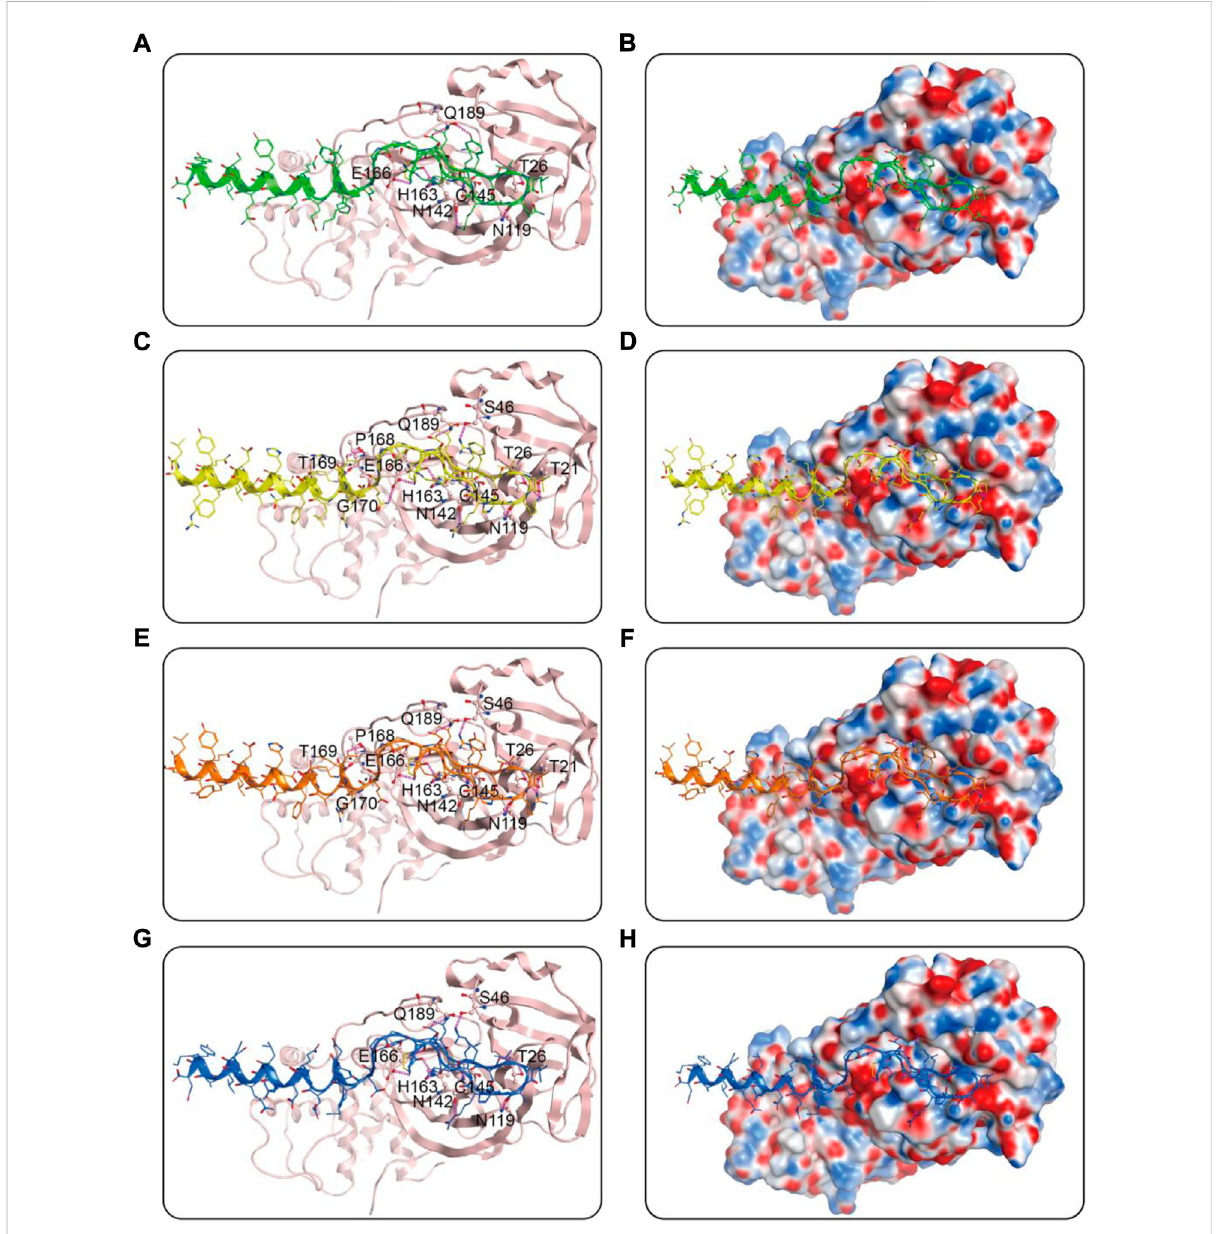
FIGURE 3 Predicted binding modes of MRs 1-4 in the active site of Mpro: (A , B) MR-1; (C , D) MR-2; (E , F) MR-3; (G , H) MR-4. The MRs 1-4 were represented asstickswiththeatomscoloredasnitrogen-blue,oxygen-red,sulfur-yellowandcarbon-green,yellow,orange,anddarkblue,respectively.Residues close to the MRs 1-4 were depicted as sticks with the atoms colored as carbon-light pink, nitrogen-blue, and oxygen-red. The hydrogen-bond interactions with protein residues were represented by purple dotted